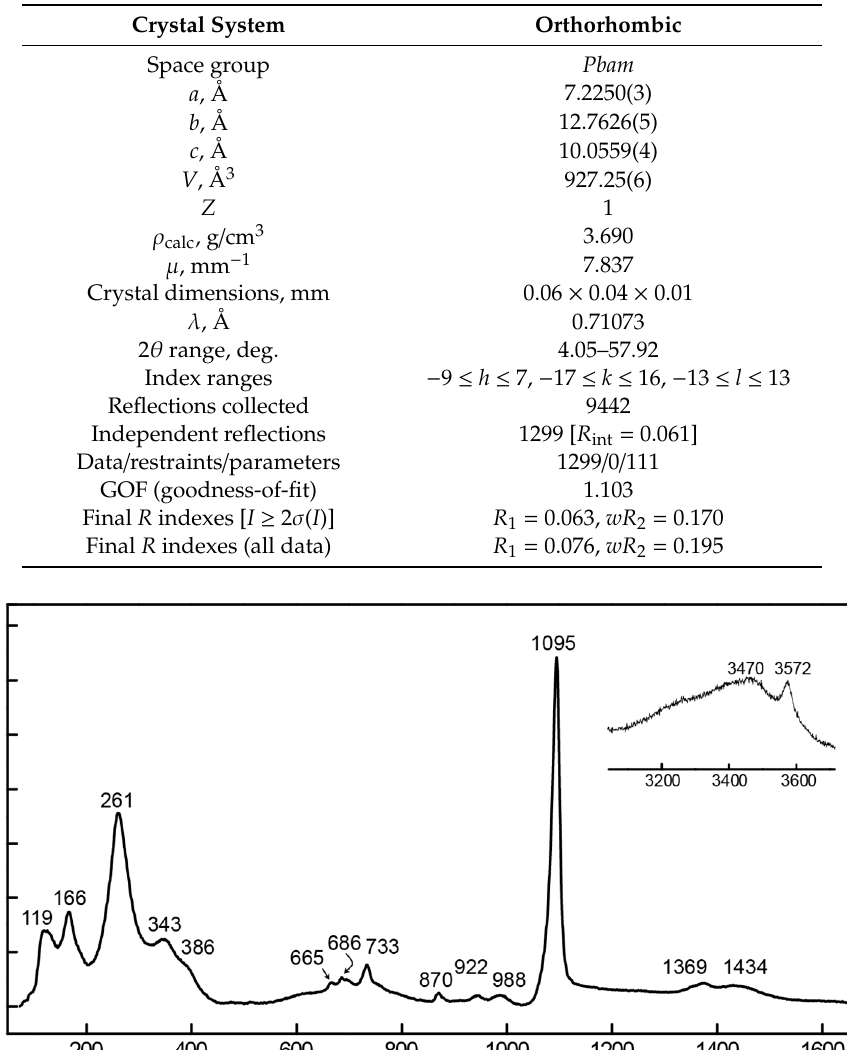
Table 1 . Crystal data and structure refinement for paratooite-(La)